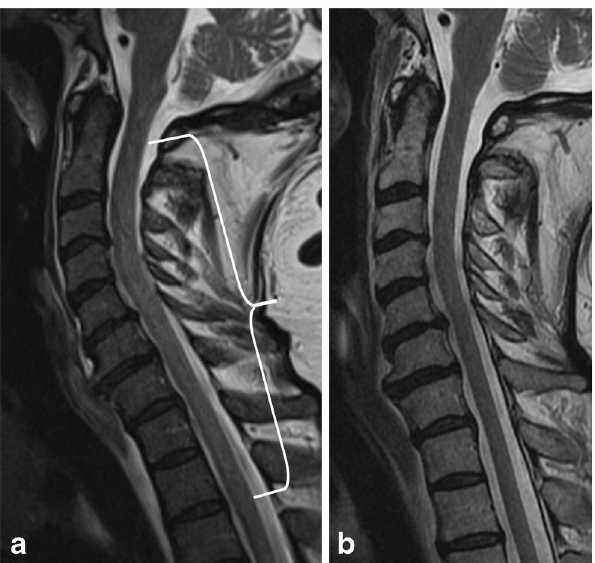
Fig. 12 Subacute combined degeneration due to vitamin B12 deficiency secondarytoperniciousanemia. A 58-year-old femalewith tinglingin her hands and feet. a Pre-treatment sagittal T2 image demonstrates a long segment of high signal in the dorsal cord (bracket). b Post-treatment sagittal T2 image demonstrates resolution of the cord signal abnormality